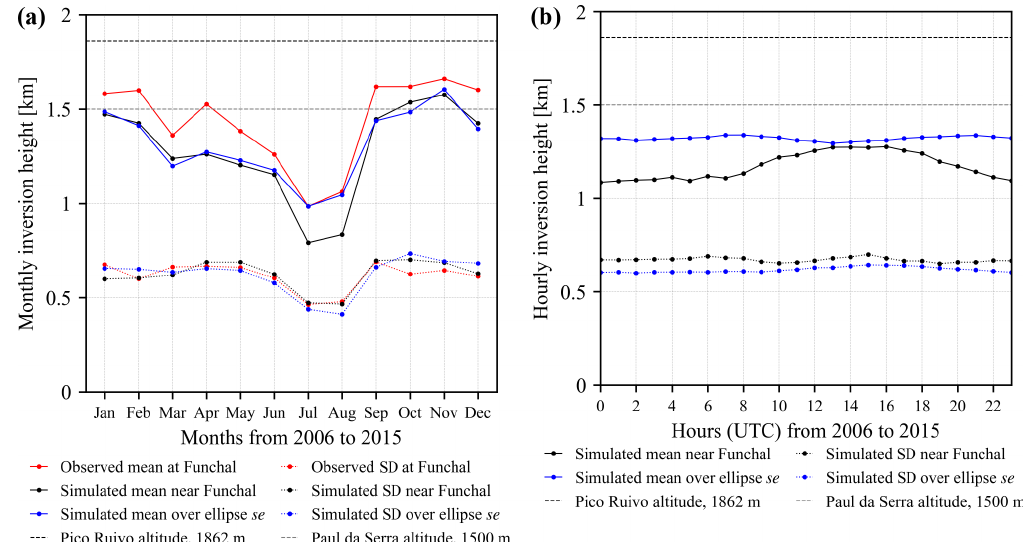
Figure 6. (a) Monthly climatology of inversion height and (b) diurnal cycle of inversion height. Both panels show monthly/hourly means and standard deviations (SDs). The observed values were calculated from the Funchal radiosonde data from IGRA 2, and the simulated values near Funchal were calculated based on the model simulation CRS1 at the grid point closest to the Funchal radiosonde station. The simulated values over se were used to represent upstream conditions where decadal 3D model outputs are available. The altitude of two mountain peaks, Pico Ruivo (1862m) and Paul da Serra (1500m) at Madeira Island, are indicated for